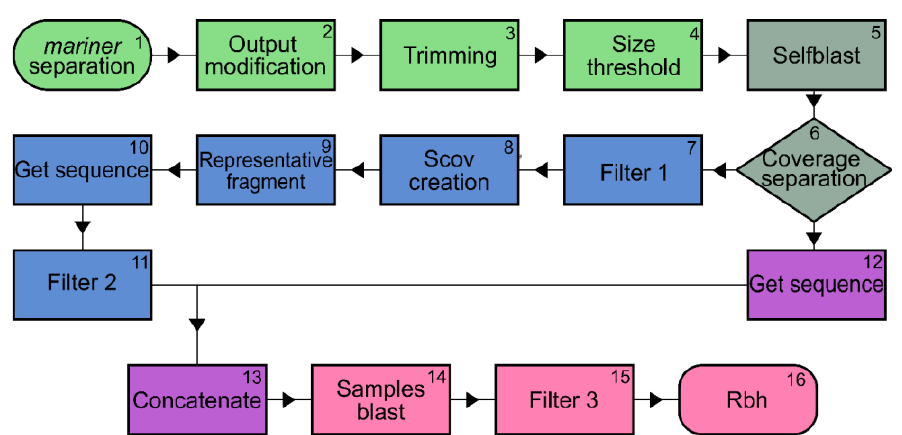
Figure 3. The flowchart demonstrates all steps of the data processing in steps 1 to 16. The colors indicate the five modules of the TISseq-Pipe pipeline, namely: Module 1: Trimming (green), Module 2: Self-blast and output organization (grey), Module 3: Removal of redundant sequences (blue), Module 4: Concatenated sequences (purple), and Module 5: Sample and reciprocal blast (pink).